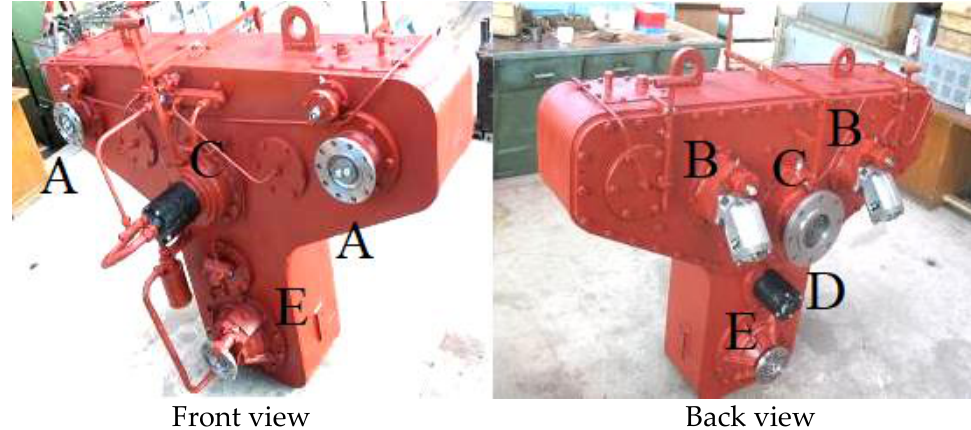
Figure 2. Adding box CSD 4000. ( A ) The input shafts; ( B ) Intermediate shafts I; ( C ) The shaft of the power take-off; ( D ) Intermediate shaft II; ( E ) The output shaft.